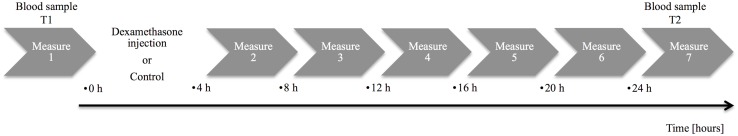
Schematic representation of the experimental set-up.